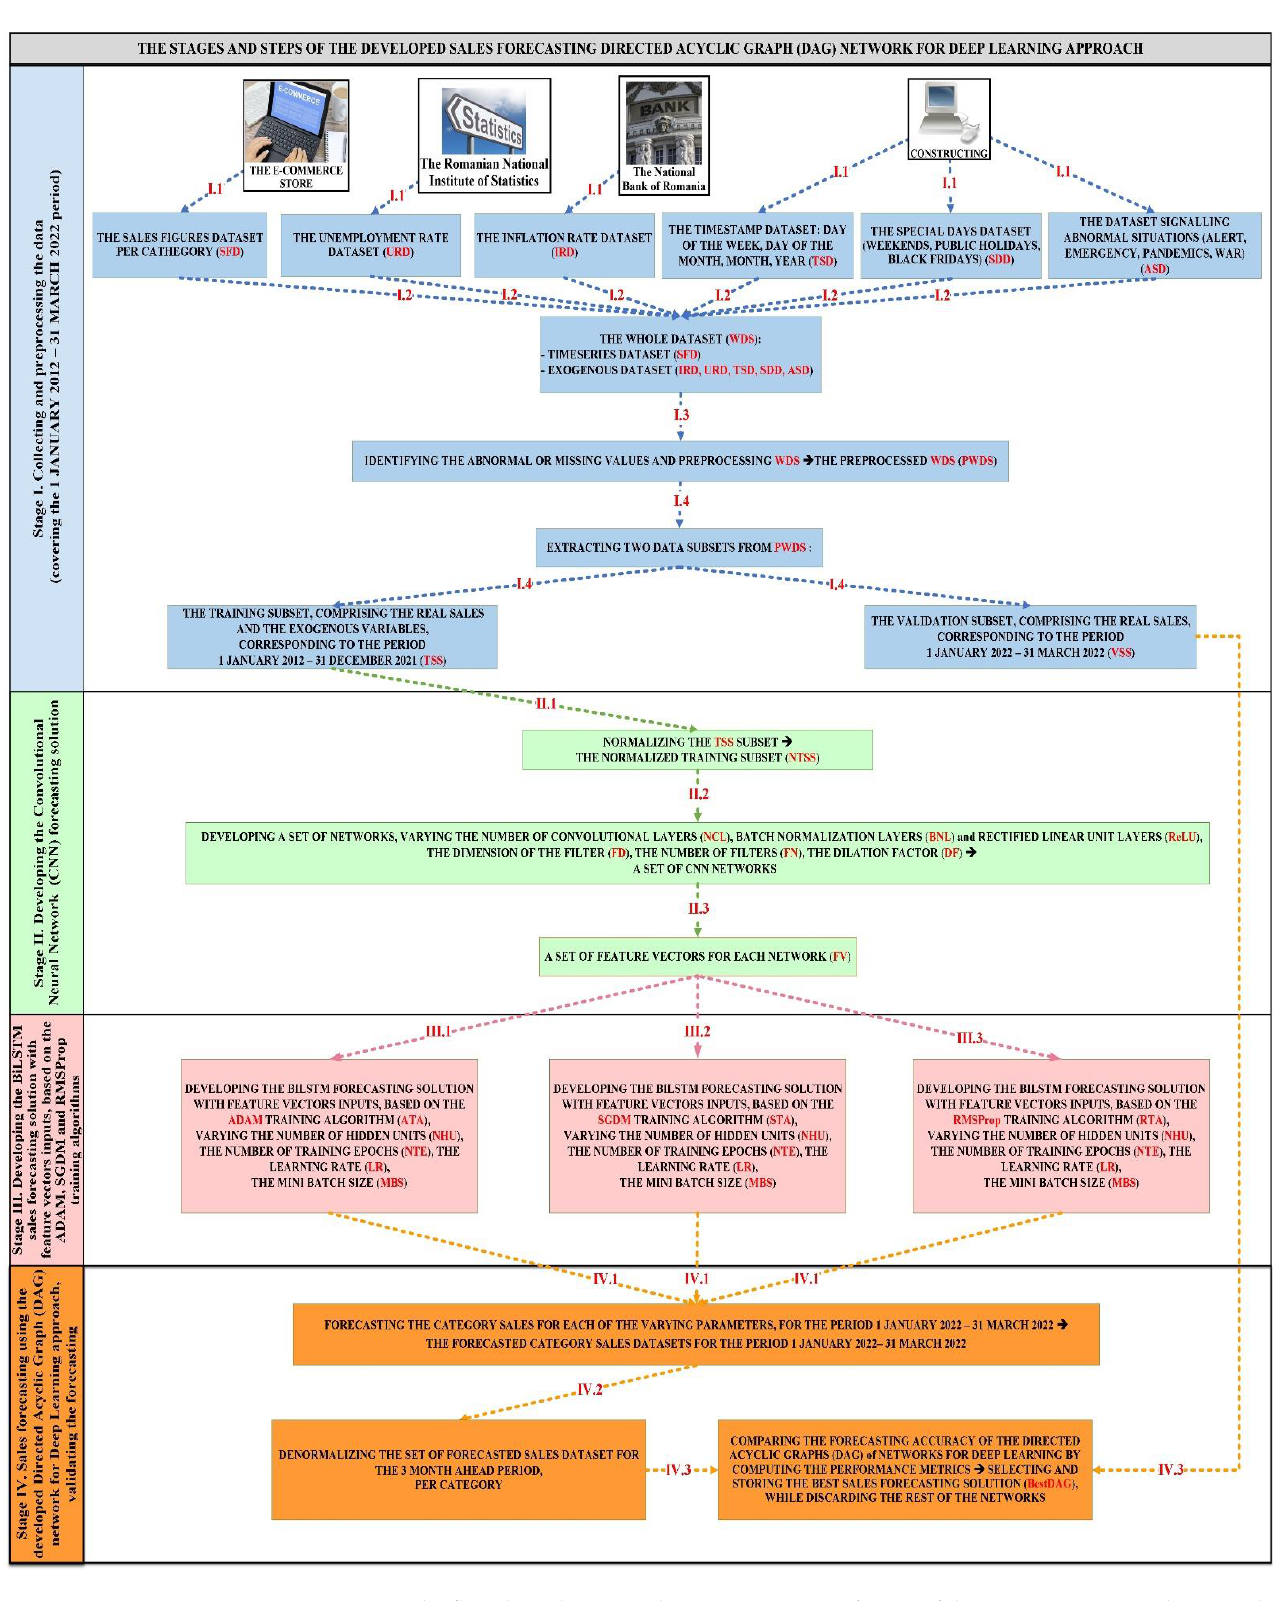
Figure 1. The flowchart depicting the main sequence of steps of the DAGNN proposed